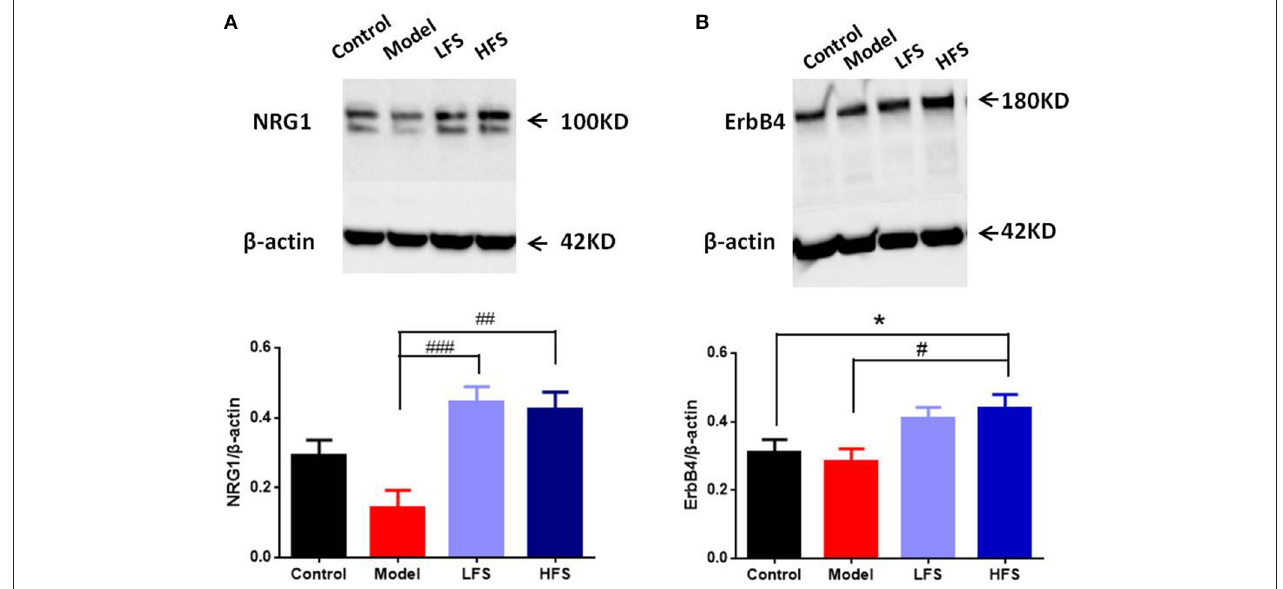
FIGURE 6 | DMS treatment restores deficient NRG1 and ErbB4 expression in cuprizone mice. (A,B) Western blot and quantitative analysis of (A) NRG1 and (B) ErbB4 protein levels in the prefrontal cortex of mice. The upper figure shows the Western blot. β -actin was used as an internal control. The bottom panel is a histogram of the quantitative values from the corresponding blot. Values are expressed as mean ± SEM ( n = 4). * P < 0.05 vs. control group; # P < 0.05, ## P < 0.01, ### P < 0.001 vs. model